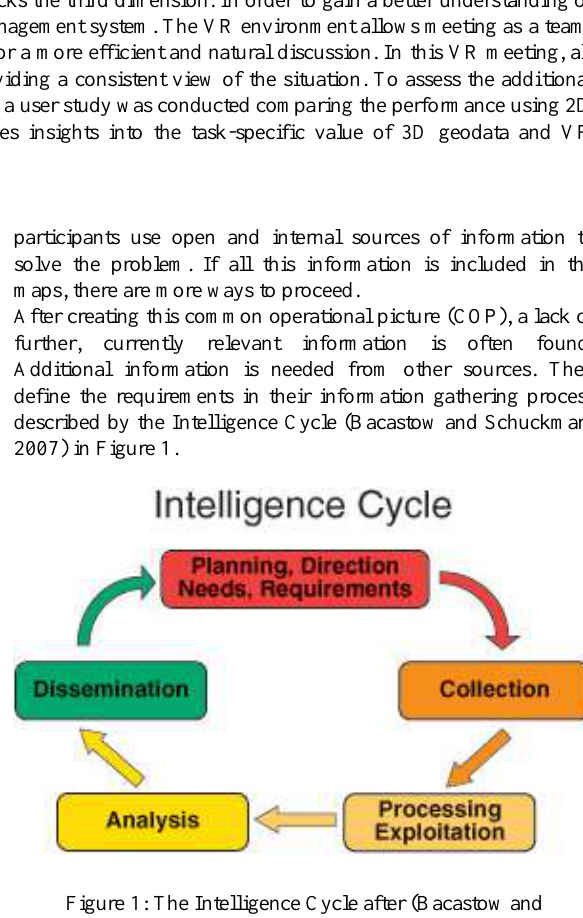
Figure 1: The Intelligence Cycle after (Bacastow and Schuckman